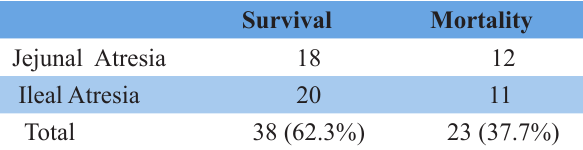
Table 4. Survival / mortality distribution of